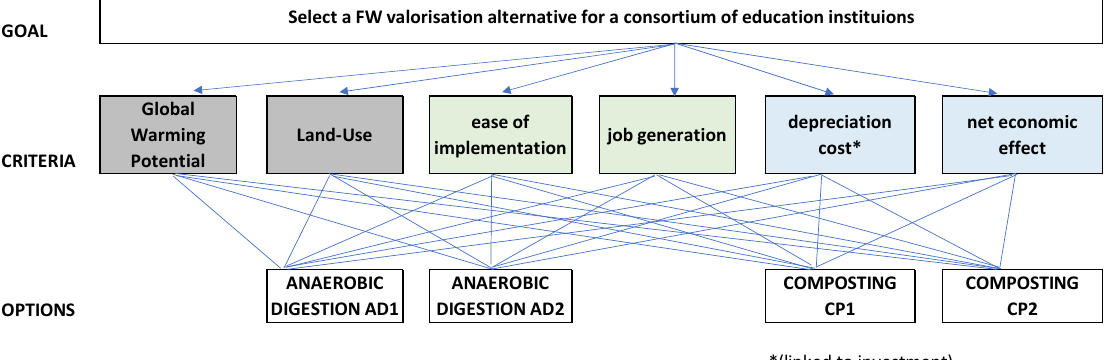
Figure 4. Analytic Hierarchy Process (AHP) structure to evaluate FW valorization alternatives for the university consortium.